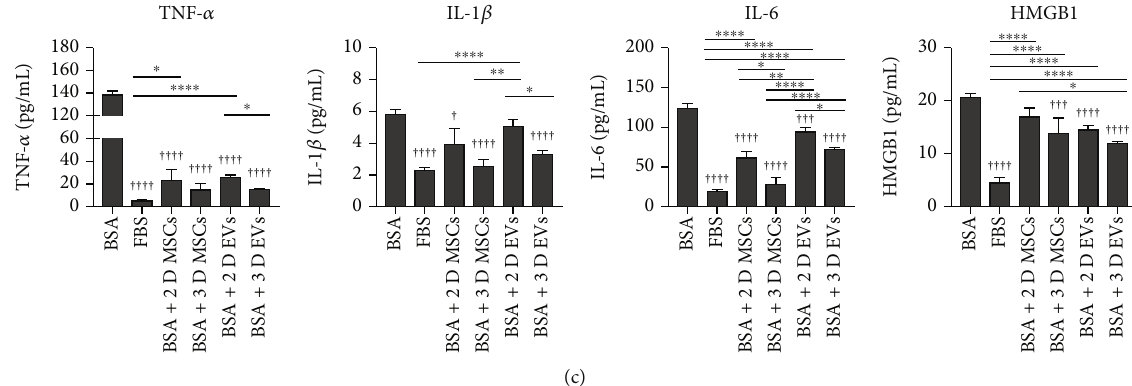
Figure 4: E ff ects of 3D hUCB-MSC-derived EVs on the expression of cytokines and insulin secretion of islets. Islets isolated from hIAPP +/- mice were cultured under four conditions: media supplemented with fetal bovine serum (FBS; FBS group), media supplemented with bovine serum albumin (BSA) without FBS (BSA group), media supplemented with BSA without FBS but with 2D hUCB-MSC (BSA+2D EV group), and media supplemented with BSA without FBS but with 3D hUCB-MSC (BSA+3D EV group). (a) Concentrations of IL-1 β , IL-18, NLRP3 in fl ammasome, caspase-1, TNF- α , IL-6, and HMGB1 in hIAPP +/- islet cells treated with EV produced by 2D- or 3D-cultured hUCB-MSCs were measured using qRT-PCR. The error bars represent the standard deviation of measurements in three separate sample runs ( n = 9 ). (b) Glucose-stimulated insulin secretion (GSIS) of hIAPP +/- mouse islets in each group. GSIS was evaluated using ELISA at 48 h after statin incubation of islets in low (60 mg/dL) and high (300mg/dL) glucose. The error bars represent the standard deviation of measurements in three separate sample runs ( n = 10 ). (c) Medium concentrations of TNF- α , IL-6, IL-1 β , and HMGB1 were measured by ELISA. The error bars represent the standard deviation of measurements in four separate sample runs ( n = 12 ). Columns, mean; bars, SD. ∗ p < 0 : 05 , ∗∗ p < 0 : 005 , ∗∗∗ p < 0 : 0005 , and ∗∗∗∗ p < 0 : 0001 . † p < 0 : 05 , †† p < 0 : 005 , ††† p < 0 : 0005 , and †††† p < 0 : 0001 compared to the BSA group by one-way ANOVA and Tukey ’ s